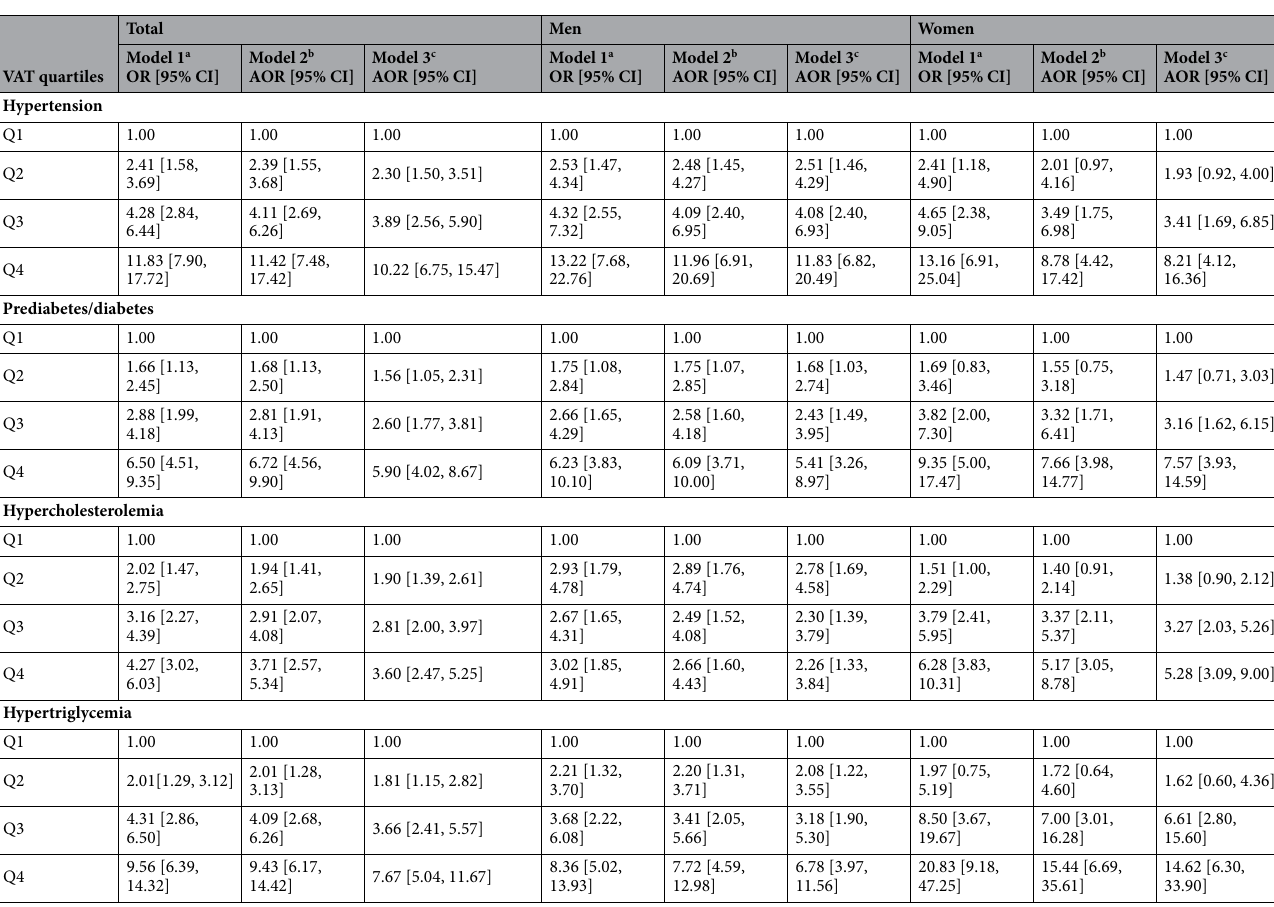
Table 2. Results of logistic regression measuring the association between cardiometabolic conditions (hypertension, prediabetes/diabetes, hypercholesterolemia, hypertriglycemia) and anthropometrically predicted visceral adiposity in models unadjusted and adjusted for participants’ lifestiles and socioeconomic characteristics: European Health Examination Survey in Luxembourg, 2013–2015 (N = 1441). Total also adjusted for sex. AOR adjusted odds ratio, CI confidence interval, OR odds ratio, VAT anthropometrically- predicted visceral adipose tissue, Q quartile. a Unadjusted model. b Model 1 adjusted for education and employment status. c Model 2 adjusted for smoking status, alcohol consumption and aerobic physical